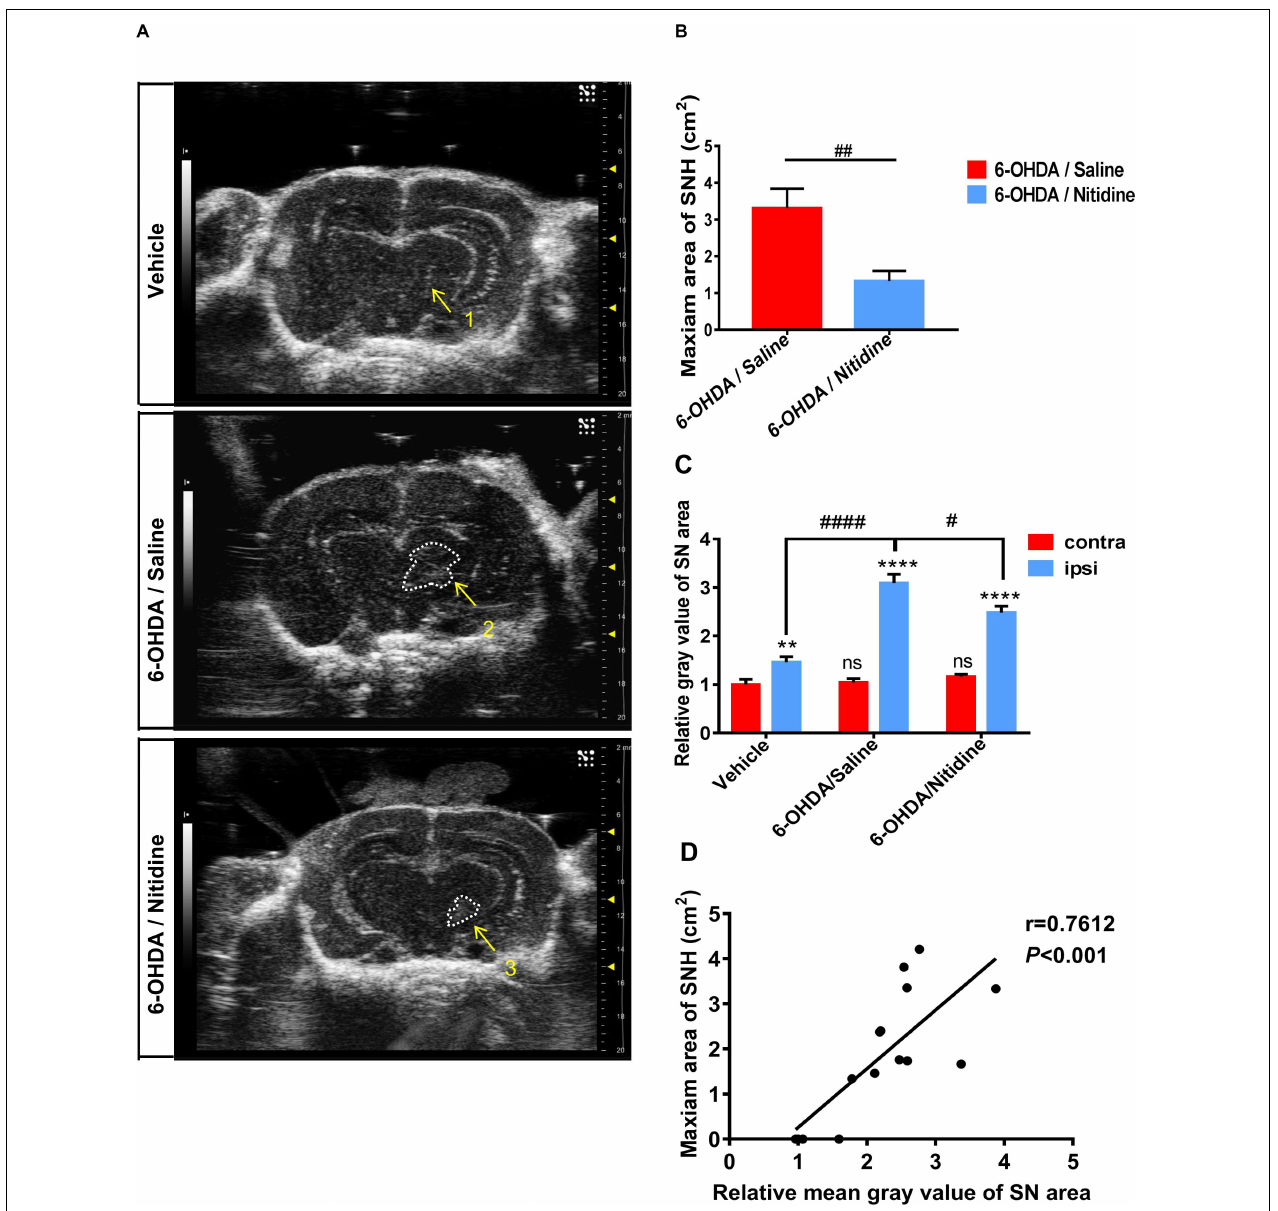
FIGURE 2 | Transcranial sonography (TCS) images and qualification of substantia nigra hyperechogenicity (SNH) after unilateral stereotactic surgery following treatment with nitidine. The rats were pretreated with nitidine (2.5 mg/kg, once daily) or sterile saline for 2 days before surgery and 15 days after surgery. (A) The TCS images showed that the SNH area in the midbrain plane of the nitidine-treated group (4, 5) was significantly smaller than that in the saline-treated group (2, 3), while only a scatter echo matching the shape of the needle emerged in the vehicle group (1). Area 2 = 4.211 cm 2 , area 3 = 3.336 cm 2 . (B) Statistical result of the maximum SNH areas in different groups ( t -test). P = 0.0069, t = 3.776, df = 7, F = 1.821. (C) Statistical results of the mean gray values of substantia nigra (SN) area. Vehicle group: t -test. P = 0.0052, t = 2.915, df = 52, F = 1.086. 6-Hydroxydopamine (6-OHDA)/saline group: t -test. P < 0.0001, t = 10.25, df = 52, F = 5.769. 6-OHDA/nitidine: t -test. P < 0.0001, t = 11.25, df = 130, F = 7.791. Comparison between contralateral sides: one-way ANOVA. P = 0.2051, F = 1.606. Comparison between ipsilateral sides: one-way ANOVA. P < 0.0001, F = 11.43. (D) Correlation analysis of mean gray values of SN areas and the maximum SNH area. P = 0.0010, r = 0.7612, R 2 = 0.5794, F = 17.9. *Comparison between contralateral and ipsilateral from a single group. # Comparison between different groups. ns P > 0.05, # P < 0.05, #### P < 0.0001, ** P < 0.01, *** P < 0.001, **** P <